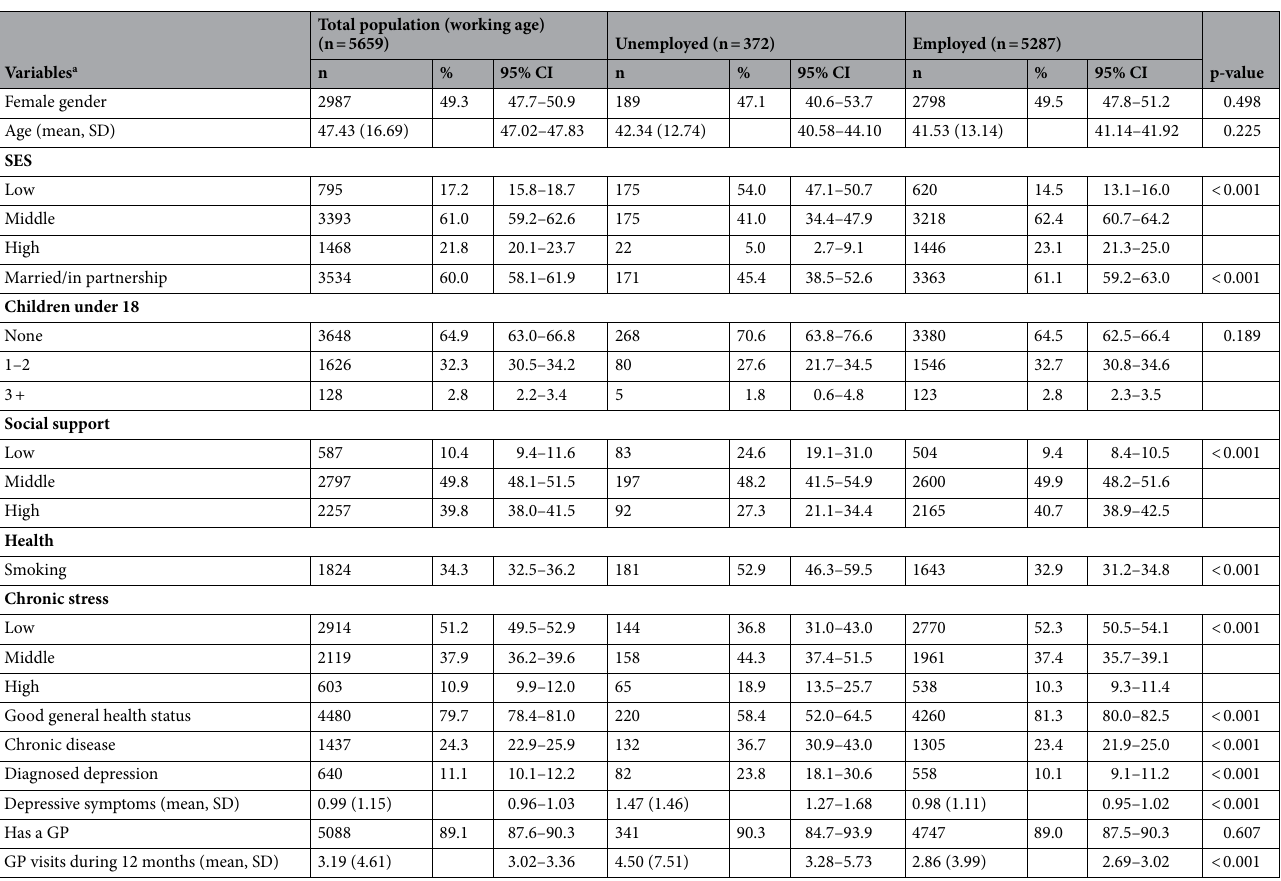
Table 1. DEGS1: Characteristics of participants (18–64 years): total and stratified by employment status (n = 5659). a Results are based on weighted data of the DEGS1.